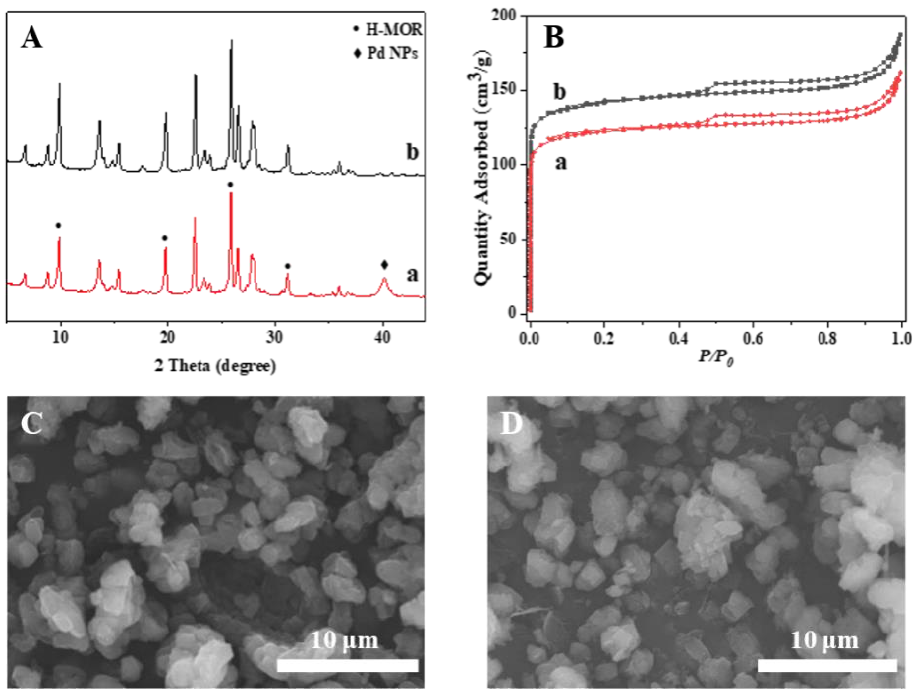
Figure 2. ( A ) XRD patterns of Pd/H-MOR (a) and H-MOR (b); ( B ) N 2 sorption isotherm of Pd/H- MOR (a) and H-MOR (b); SEM images (scale bar 10 µ m) of Pd/H-MOR ( C ) and H-MOR ( D ). Table 1. Optimization of reaction conditions a .